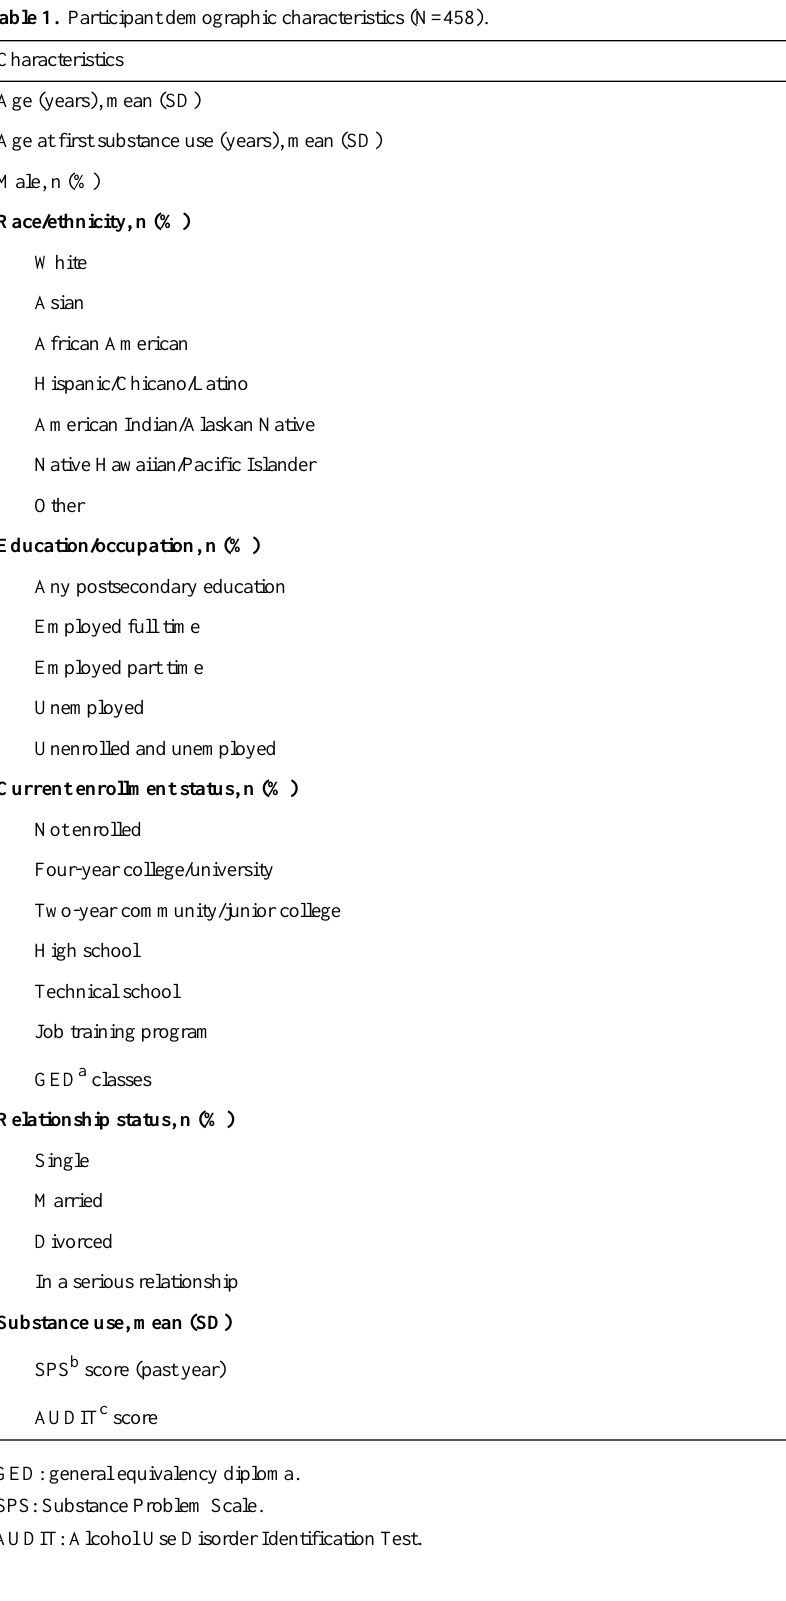
Table 1. Participant demographic characteristics